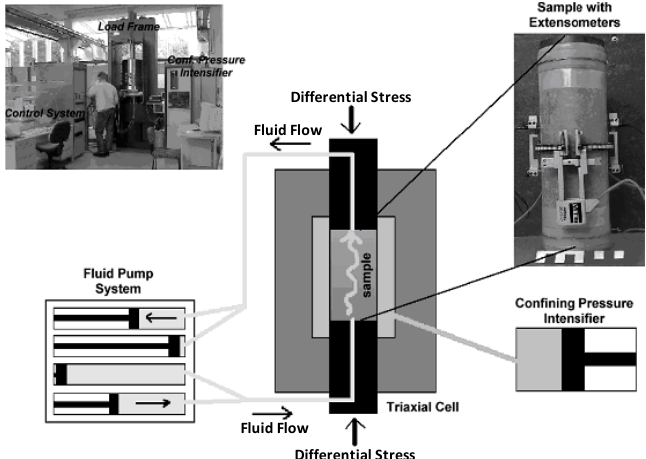
Figure 2. Experimental configuration for MTS 815.02 tests .